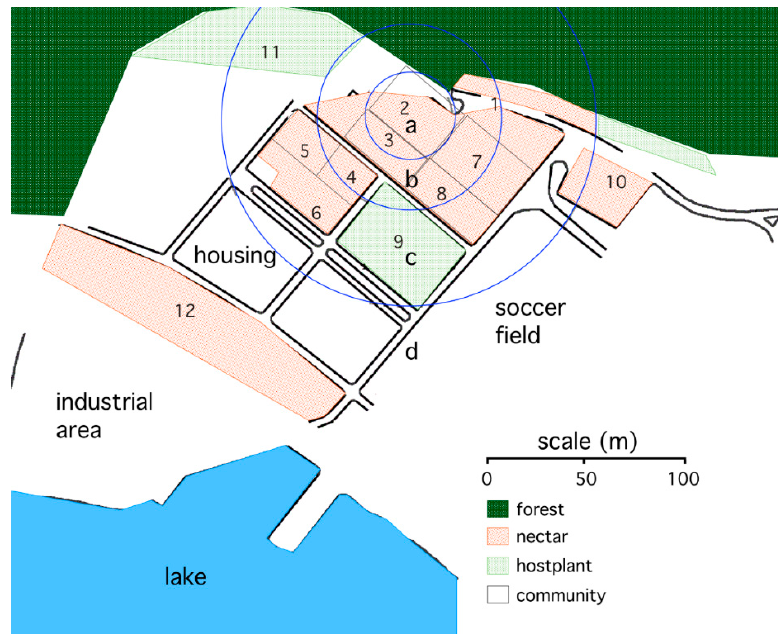
Figure 1. Map of the study site in Gamboa, Panama, and general characteristics of the habitats. Recapture sites (numbered areas) were classified into one of four zones (a through d) defined by concentric circles measured from the point of release to the center of the site. Habitats abundant with nectar and hostplants were bounded by habitats of poor quality for the butterflies, including forest, community housing, grass parks, and the lake.